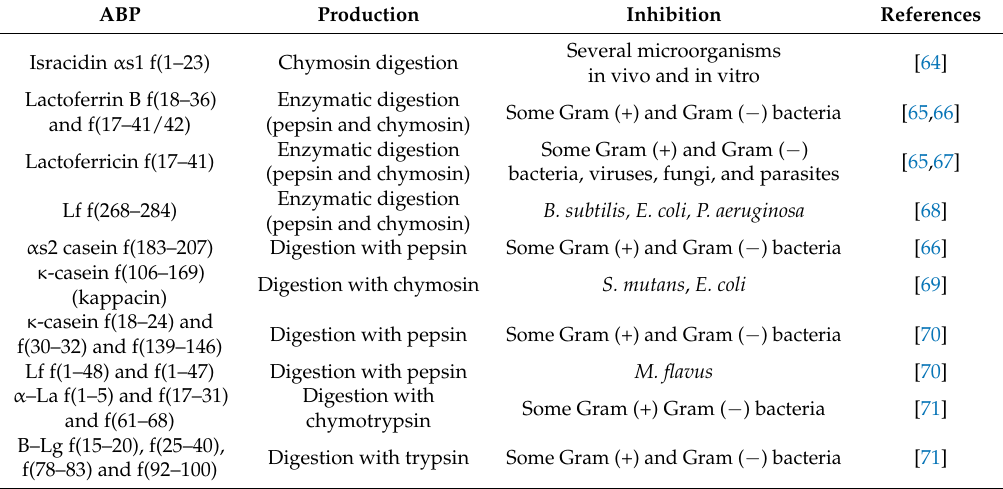
Table 3. Summary of milk-derived ABPs and their antibacterial effect (adopted from [60]).